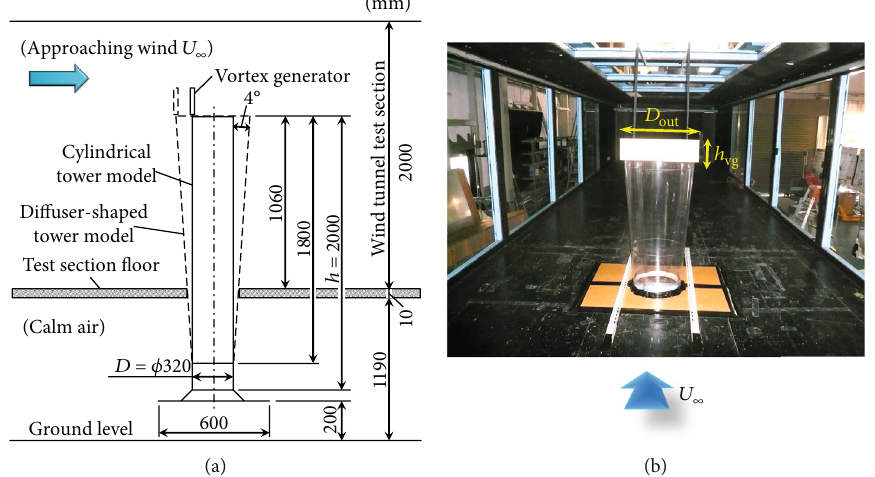
Figure 2: The tower model set-up in the wind tunnel experiments: (a) dimensions of the tower model and its set-up; (b) in situ photograph of the tower and the vortex generator in the wind